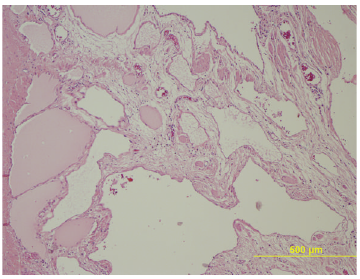
Figure 5: Histological sample—ectatic lymphatic vessels inside the mass (H & E,